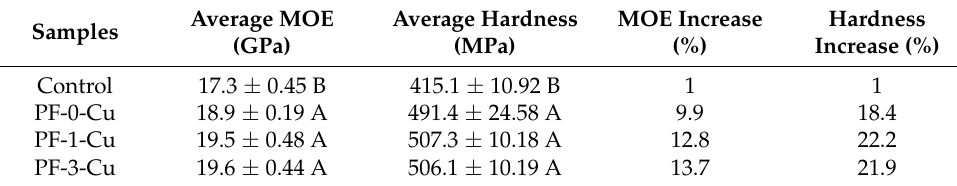
Figure 7. Micromechanical properties of samples before and after modification treatment ( a ) elastic modulus, ( b ) hardness. Table 4. Changes in cell walls mechanical properties of samples before and after modification